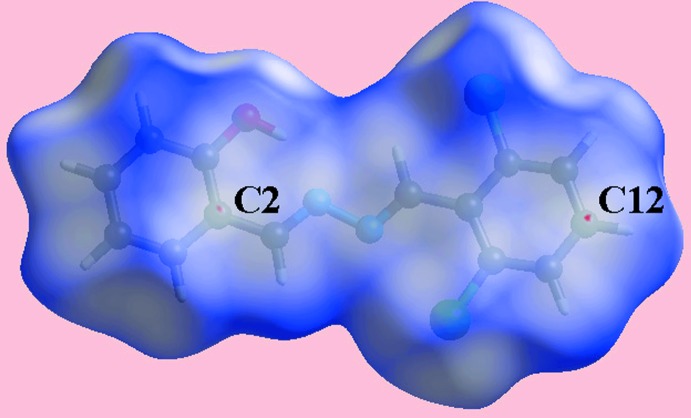
A view of the Hirshfeld surface for (I) mapped over d
norm in the range −0.001 to + 1.301 (arbitrary units), highlighting diminutive red spots near the C2 and C12 atoms owing to their participation in C⋯C contacts.